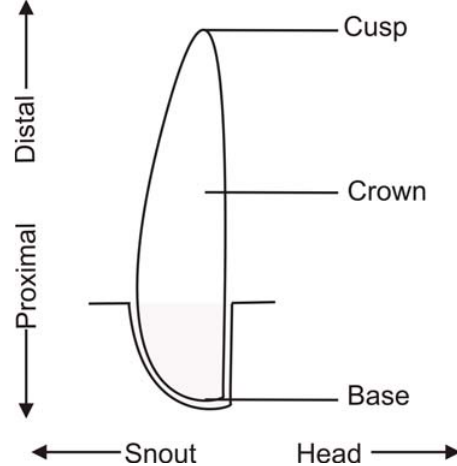
Fig. 1 . Rostral teeth